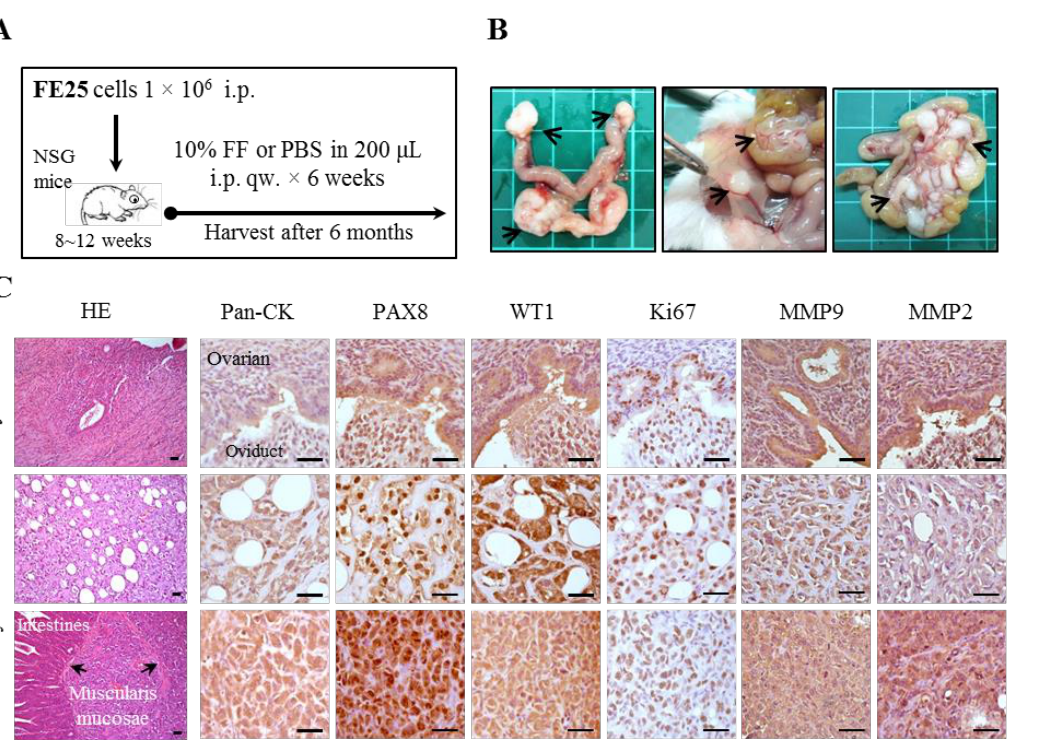
Figure 1. FF promotes intraperitoneal tumorigenesis of human immortalized fimbrial epithelial cells and HGSC cells. NSG mice were injected intraperitoneally with 1 × 10 6 FE25 ( A – C ), OVSAHO ( D – G ) or KUROMACHI ( H – J ) cells. ( A , D ) Ten percent FF or PBS was co-injected with the cells and was given as boosters weekly or twice weekly for six weeks. Mice